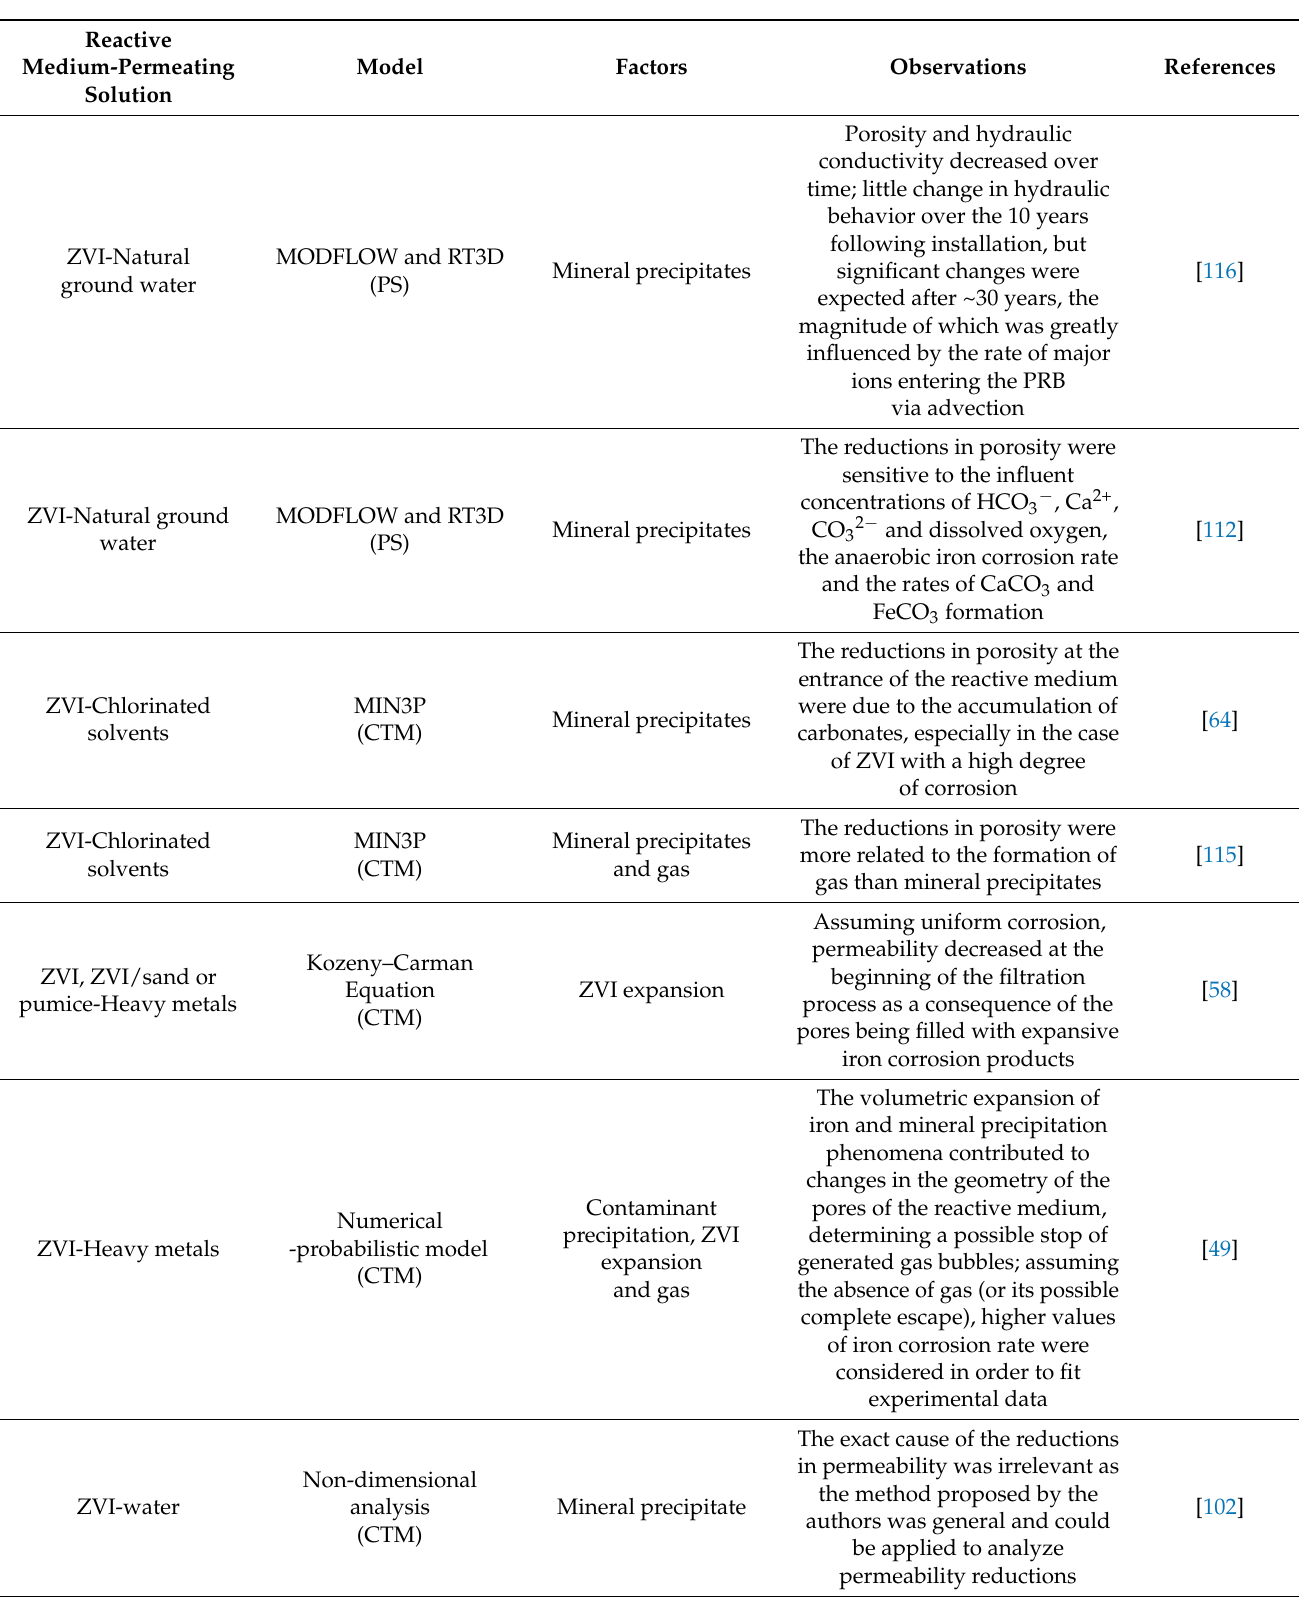
Table 4. The results obtained using mathematical models to predict the hydraulic behavior of